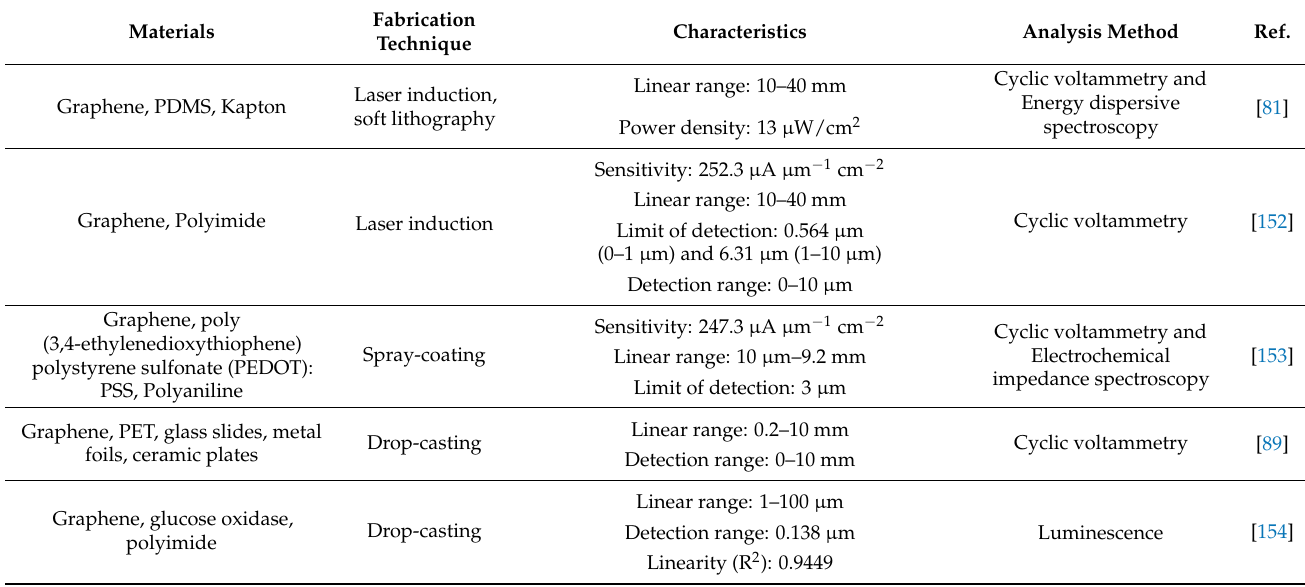
Table 5. Summary of the performances of the un-functionalized LIG-based sensors for glucose detection. Fabrication Materials Technique